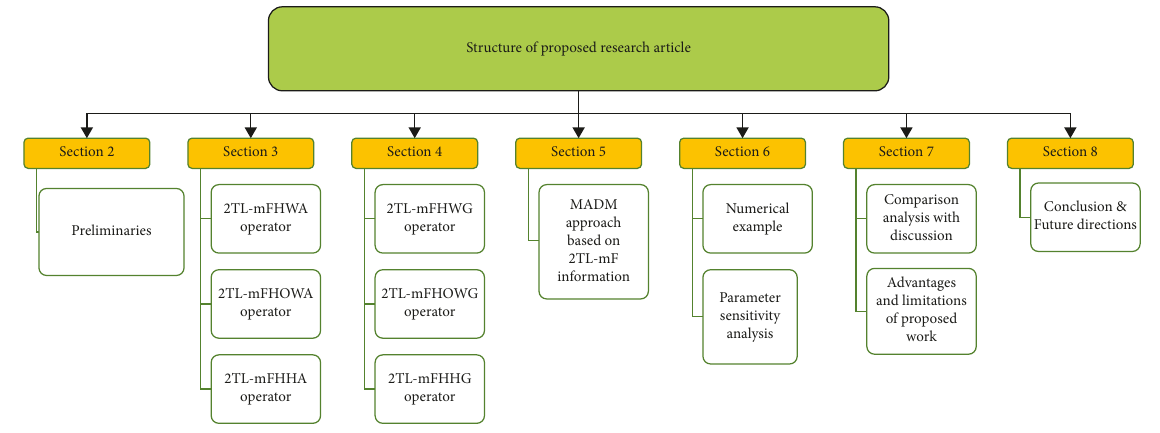
Figure 1: Structure of the proposed research